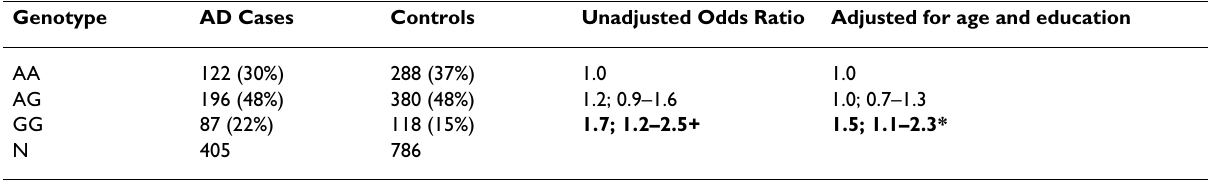
Table 4: Genotype frequencies of the -386G/A P3 promoter polymorphism in AD cases and controls Genotype